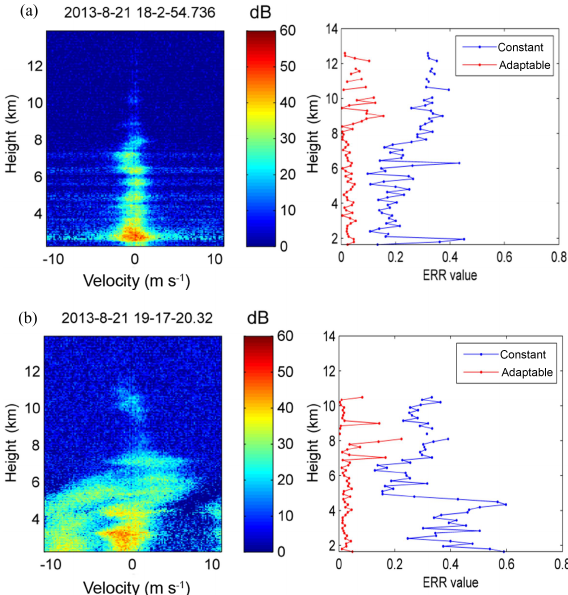
Figure 4. (a) Left: Capon RIM power spectra of atmospheric echoes at the moment indicated by the blue arrow in Fig. 3a (data time and date: 18:02:54UT, 21 August 2013); right: height variations of the MSEs obtained with constant and adaptable corrections. (b) Same as (a) but for the circumstances with precipitation at the moment in- dicated by the red arrow in Fig. 3a (data time and date: 19:17:20UT, 21 August